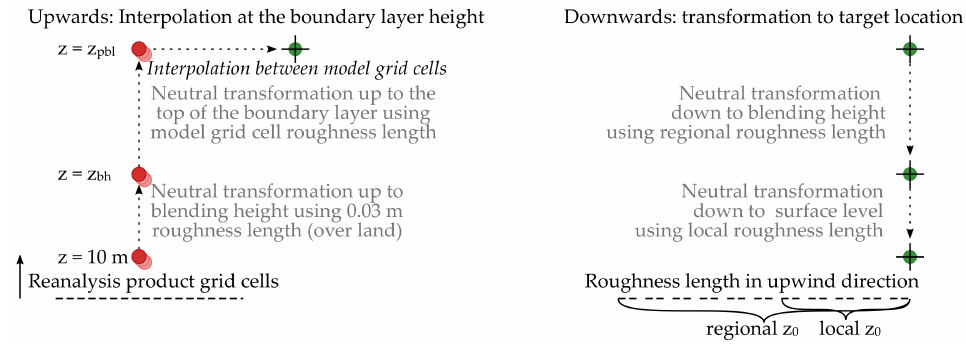
Figure 4. The 2-layer downscaling model concept applied to the reanalysis model surface